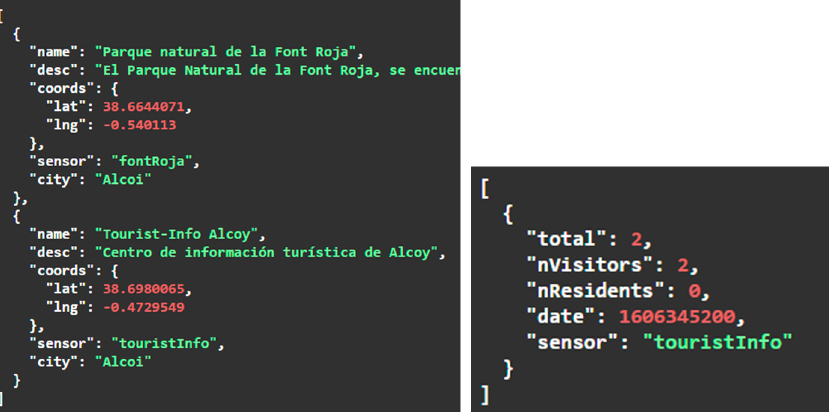
Figure 3. Excerpt example for /places ( left ), and for /summaryInfo ( right ).